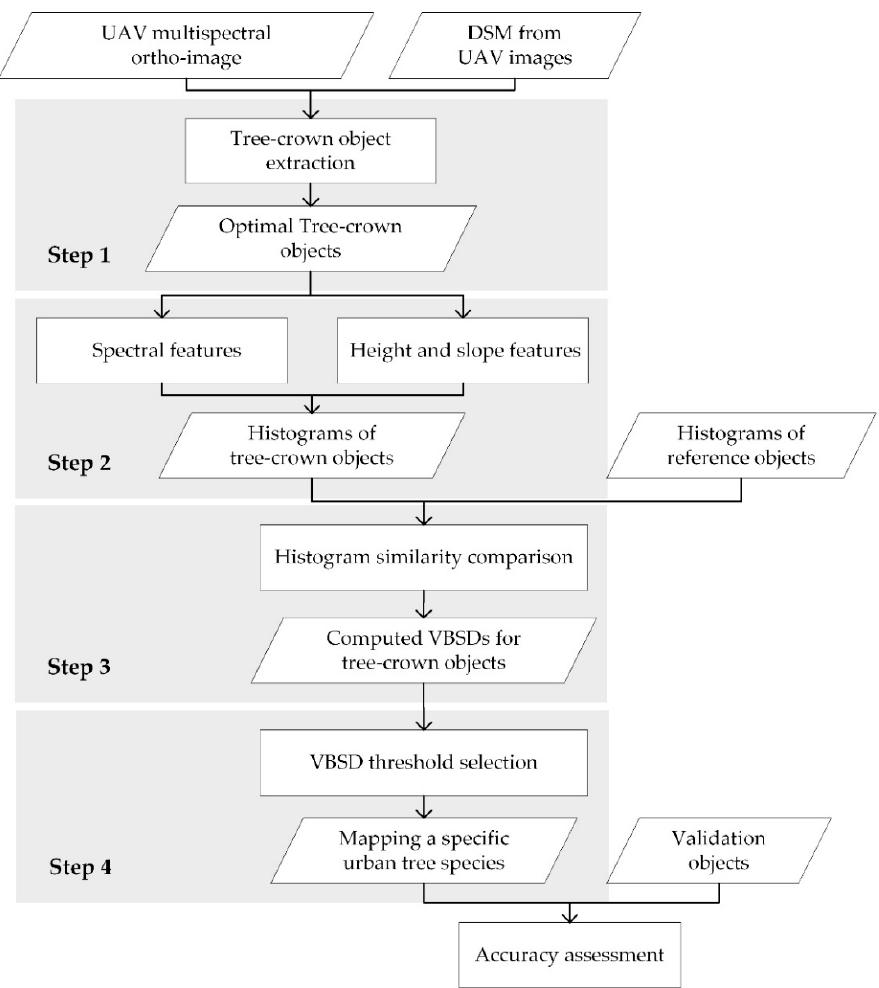
Figure 2. Flowchart of our proposed tree species mapping method. The histogram similarity measure used is Variable Bin Size Distance (VBSD).